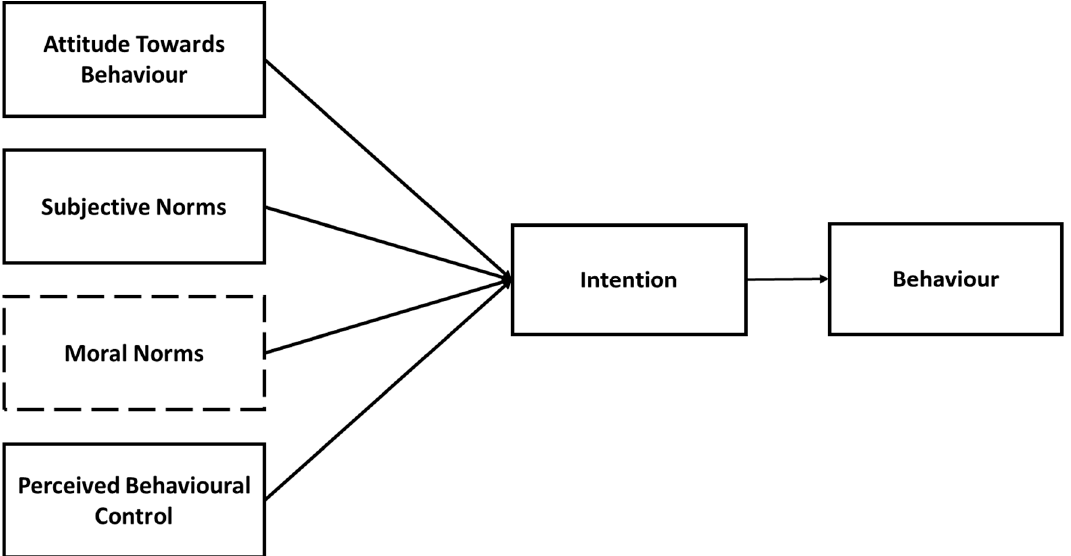
Figure 4. Components of the TPB and their influence on the final behaviour . Source: Adapted from Fishbein and Ajzen [60].